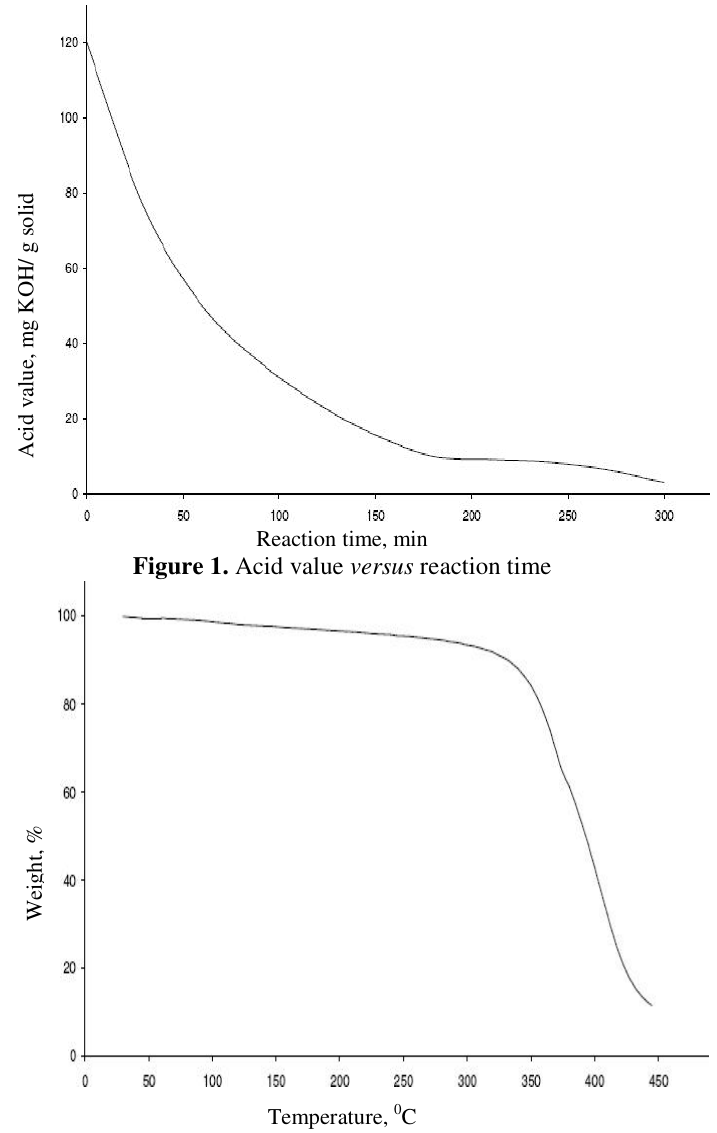
Figure 2 . TGA traces of epoxy acrylate with EOPA ( sample